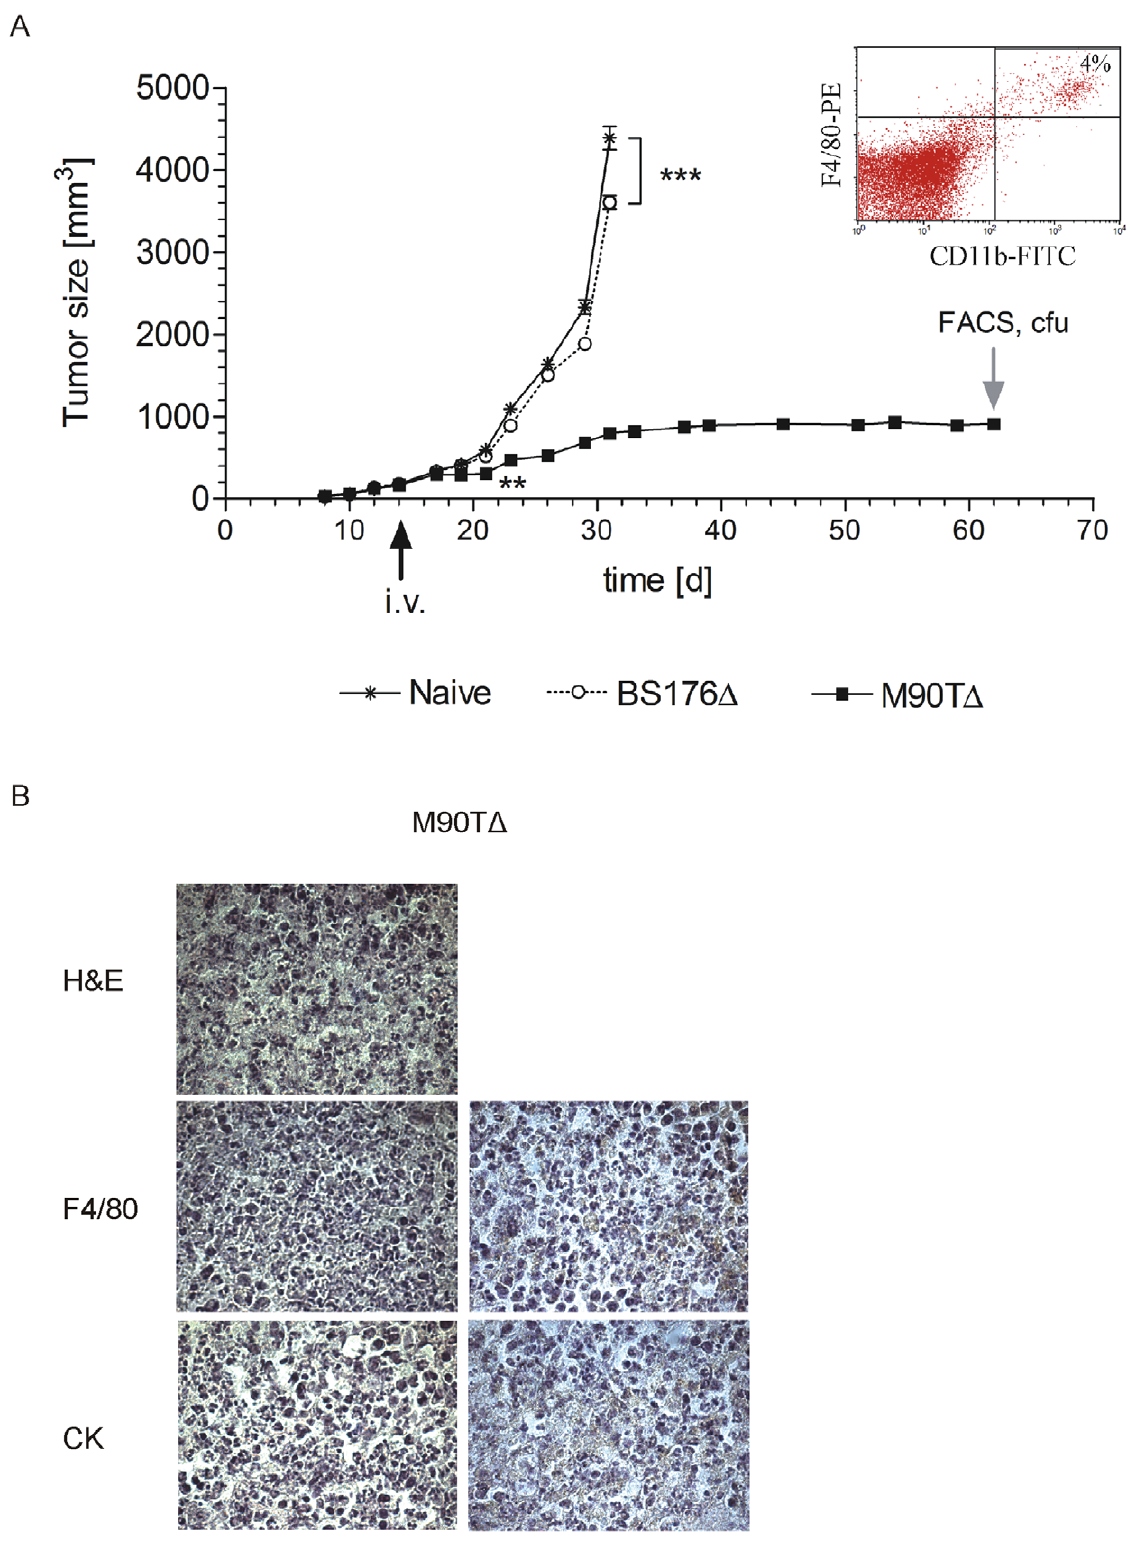
Figure 5. M90T D , but not BS176 D , completely blocked tumor growth after i.v. infection of 4T1 tumor-bearing mice. (A) 14 days after tumor cell inoculation 1 6 10 6 bacteria were applied i.v. to 8 mice per group. Non-infected and BS176 D infected mice were sacrificed 31 days after tumor cell inoculation. At day 62, M90T D mice were killed and CFU and macrophage numbers were determined. ** P , 0.01, *** P , 0.001. (B) Histology of tumor tissue from M90T D -infected mice. Left panels represent antibody controls. Scale bars represent 50 m m. BS176 D ; Shigella flexneri BS176 D aroA ; M90T D ; Shigella flexneri M90T D aroA ;CK: Cytokeratin.